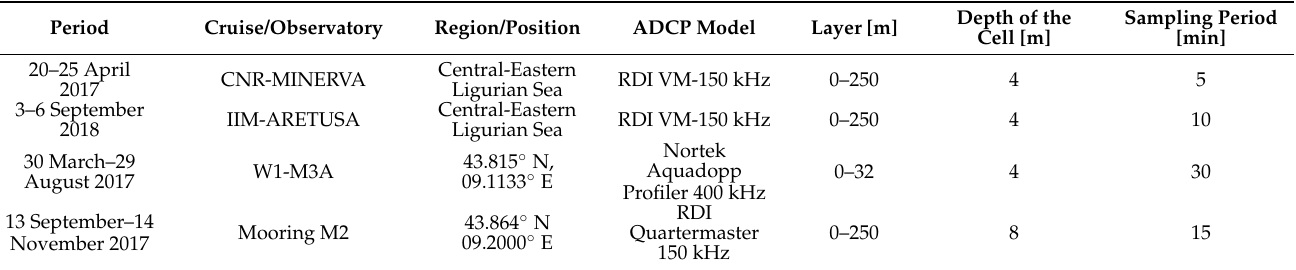
Table 1. Details of the analyzed acoustic dataset provided by deployed